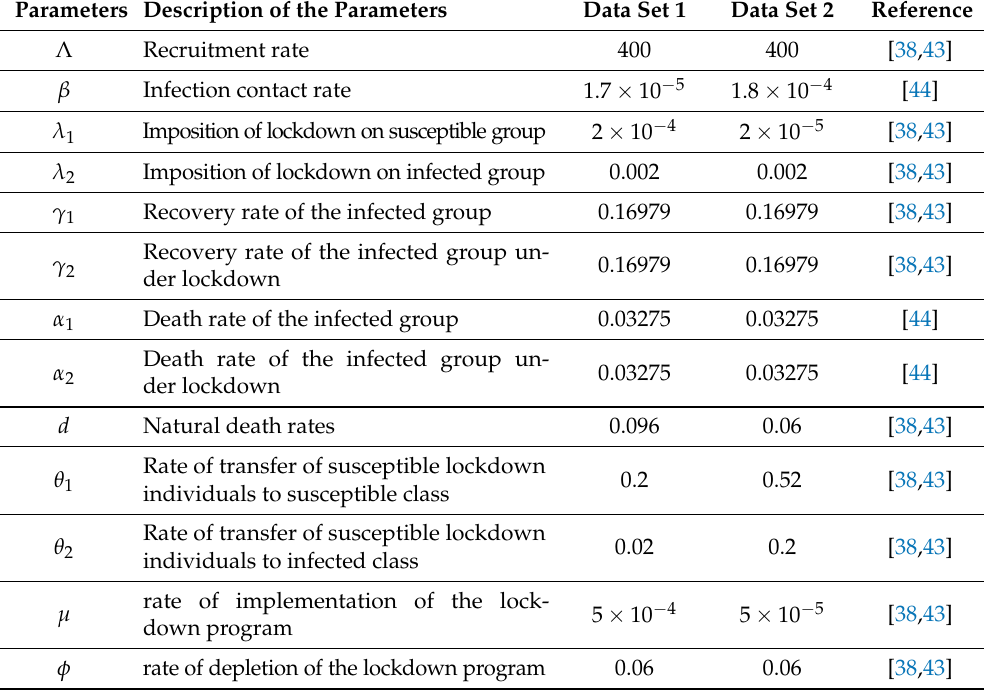
Table 2. Input parameter values used to simulate the trajectories of the solution of the model as shown in Figures 1–4. The parameters under the column data set 1 will result R 0 = 0.2373 < 1, and the parameters under data set 2 yield R 0 = 4.5707 >